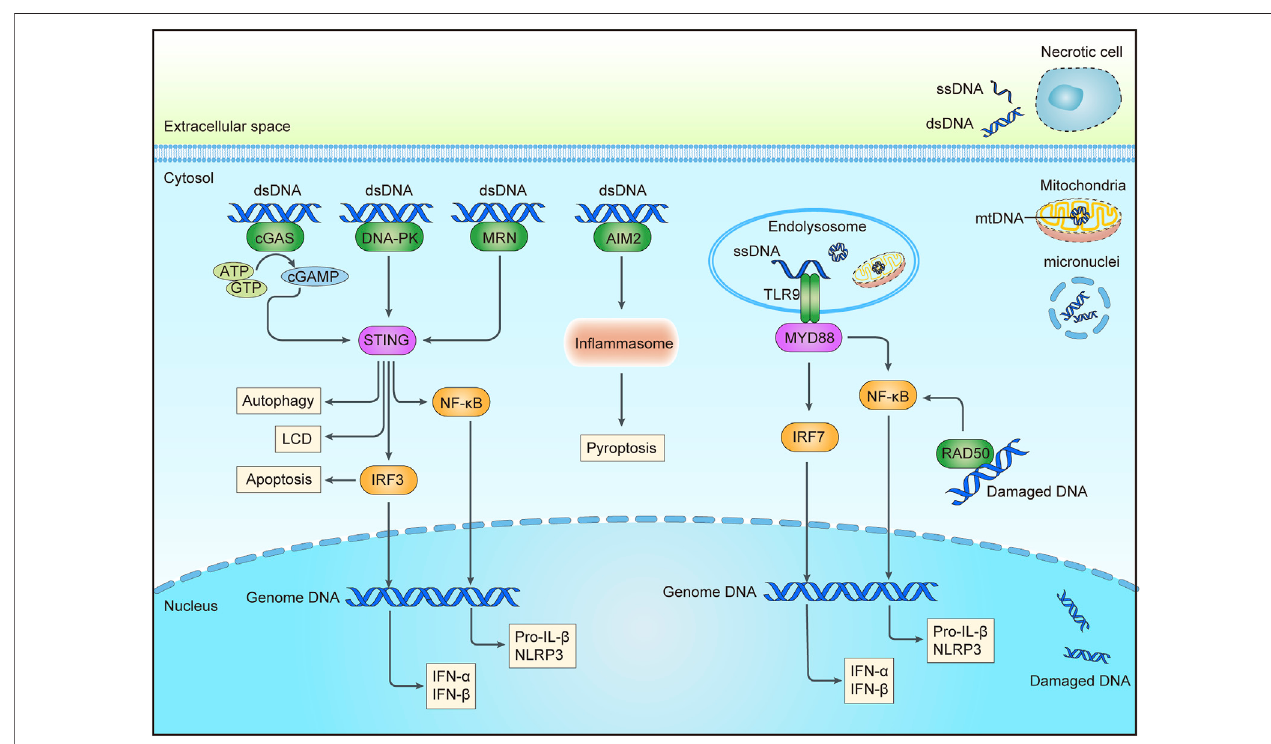
FIGURE 1 | DNA sensing pathways triggered by DNA damage. An abnormal increase of intracellular DNA could come from the nucleus, micronuclei, or mitochondria after chemotherapy or radiation. DNA in endosomal may be from extracellular DNA of necrotic cells through endocytosis or cytoplasmic DNA through autophagy. Sensors for DNA are shown in green, including cGAS, DNA-PK, MRN, AIM2, and RAD50 in the cytoplasm, and TLR9 in the endolysosome. Adaptor moleculesareshown inpinkand downstreamsignaling molecules areshowninyellow.Activation ofthese pathways may resultintheproduction ofinterferon (IFN) and other cytokines, apoptosis, pyroptosis, autophagy, etc., cGAS, cyclic GMP-AMP synthase; DNA-PK, DNA-dependent protein kinase complex; MRN, Mre11- Rad50-Nbs1 complex; AIM2, absent in melanoma 2; TLR9, Toll-like receptor 9; cGAMP, cyclic GMP-AMP; STING, stimulator of interferon genes; MYD88, myeloid differentiationprimaryresponseprotein88;IRF3/7,interferonregulatoryfactor3/7;NF- κ B,nuclearfactor- κ B;NLRP3,NOD-,LRR-andpyrindomain-containing3;LCD, a lytic cell death program; dsDNA, double stranded DNA; ssDNA, single stranded DNA; mtDNA, mitochondrial DNA.